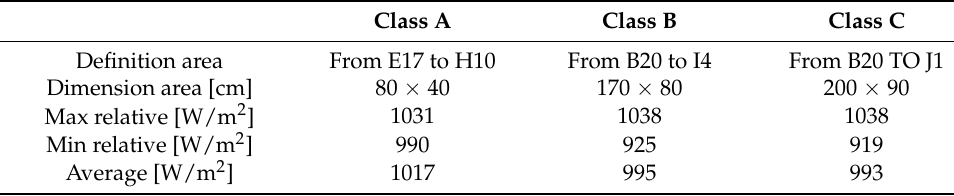
Table 4. Class parameters in testing area.